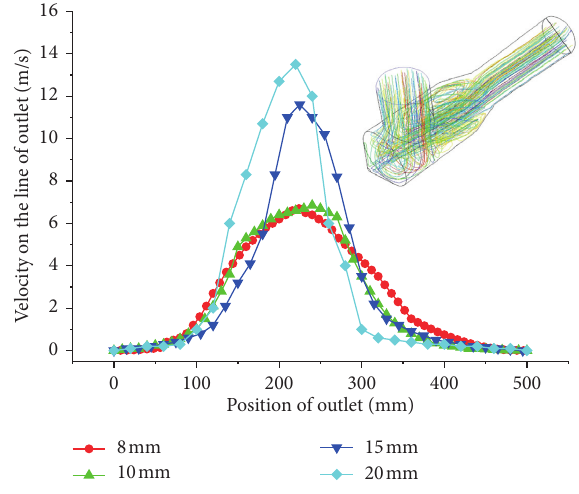
Figure 4: The results of velocity in different mesh